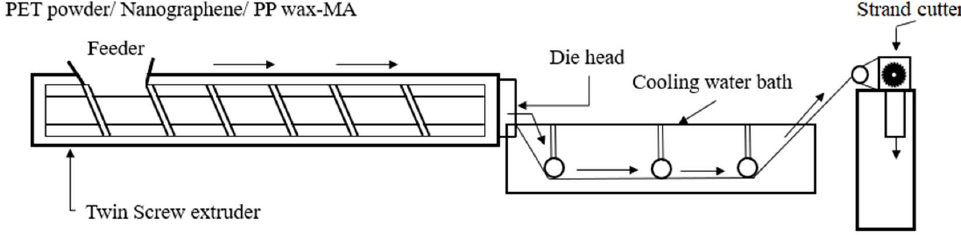
Figure 1. The processing diagram of a twin-screw extruder.